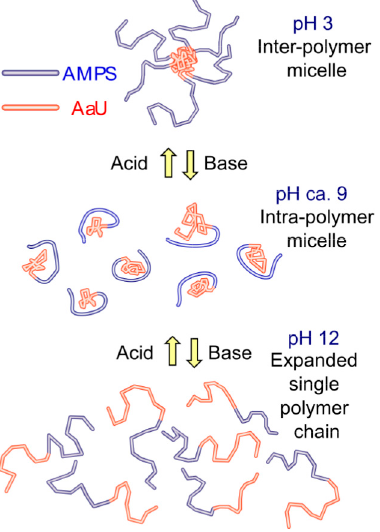
Figure 7. Conceptual illustration of pH-induced association behavior of PAMPS–PAaU in 0.1 M NaCl aqueous solutions.